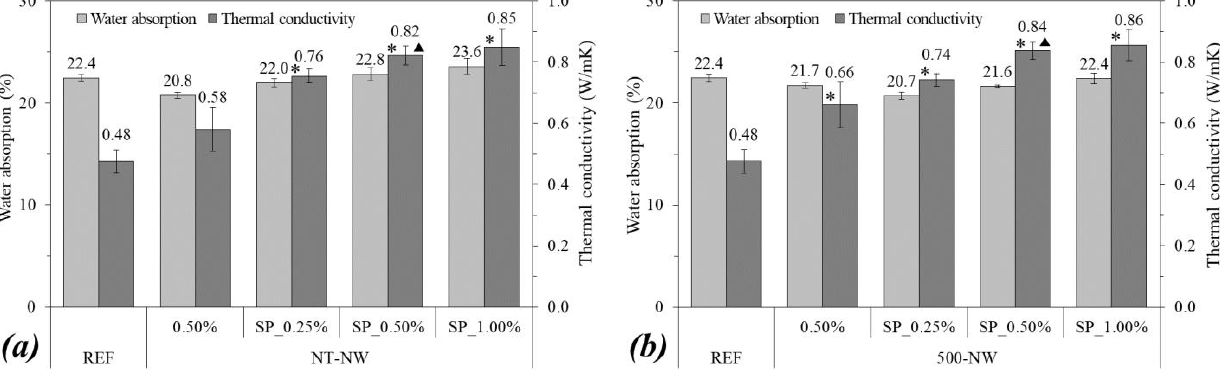
Figure 8. Water absorption and thermal conductivity of ( a ) NT-NWs cement composites and ( b ) 500-NWs cement composites, at 28 days of hydration. Error bars correspond to ±1 standard deviation. Stars indicate significant differences in comparison with REF and triangles indicate significant differences between the samples with and without SP.